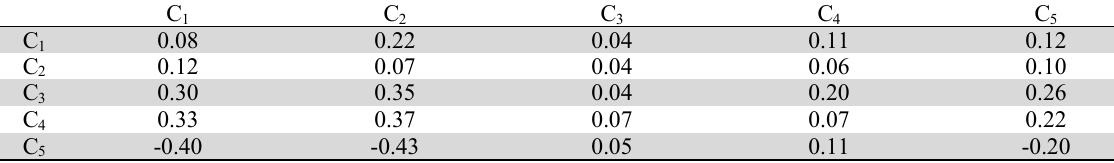
Defuzified total-relation matrix